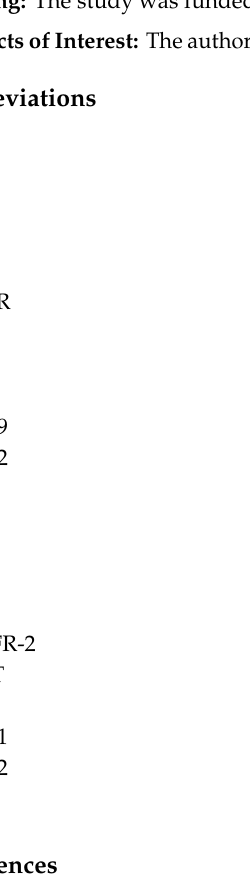
Figure S1: Title. Clinical and radiological pictures of Patients 1 and 2 hands with characteristic appearance of sclerodactylia. Table S1: Title. Calculation of TIMP and MMP molecular weights for stoichiometric